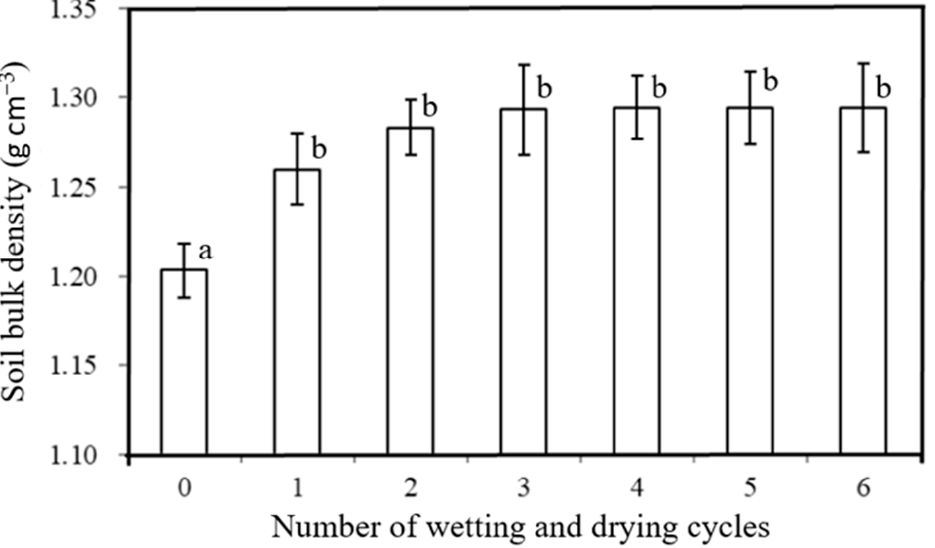
Figure 3. Soil bulk density as affected by number of wetting and drying cycles. Each half bar represents one standard deviation ( n = 3). Means with the same lowercase letter are not significantly different ( p ≤ 0.05).